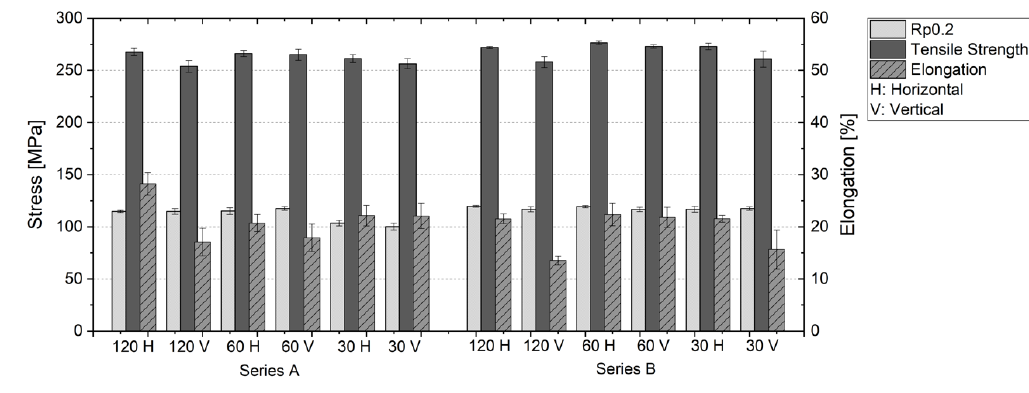
Figure 9. Tensile properties of WAAM processed Al-5356.